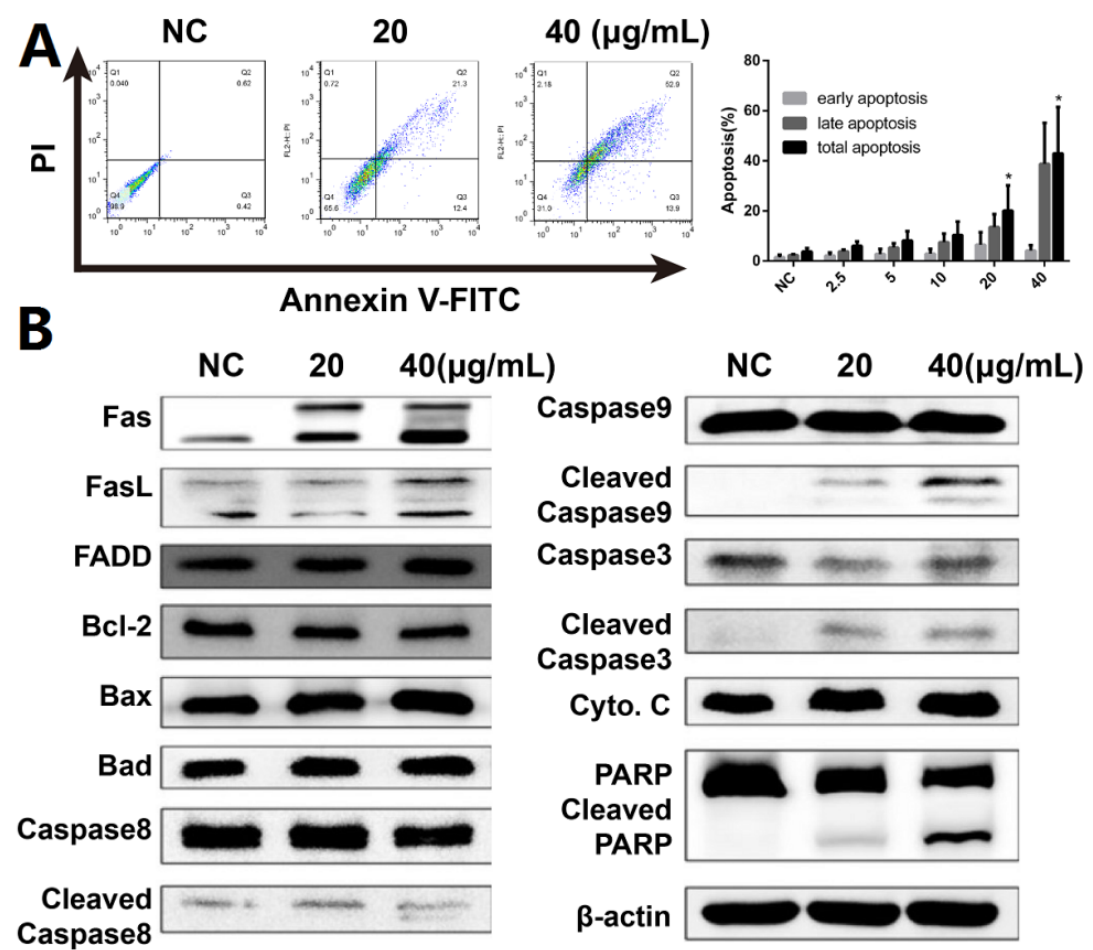
Figure 2. ( A ). A375 cells were incubated with various concentrations (0, 20, or 40 µ g / mL) of DHP1808 for 24 h. Cell death were examined by Annexin V / PI double stained assay; ( B ). A375 cells were incubated with various concentrations (0, 20, or 40 µ g / mL) of DHP1808 for 24 h. The expression levels of apoptosis-related proteins were determined by western blot analysis. Data represent means ± SD at least three independent experiments, * p < 0.05 versus the control group.